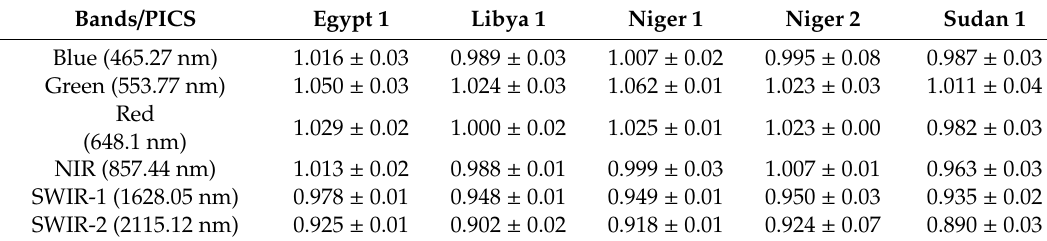
Table 4. Mean k-scale Factors derived from MODIS / Hyperion near coincident